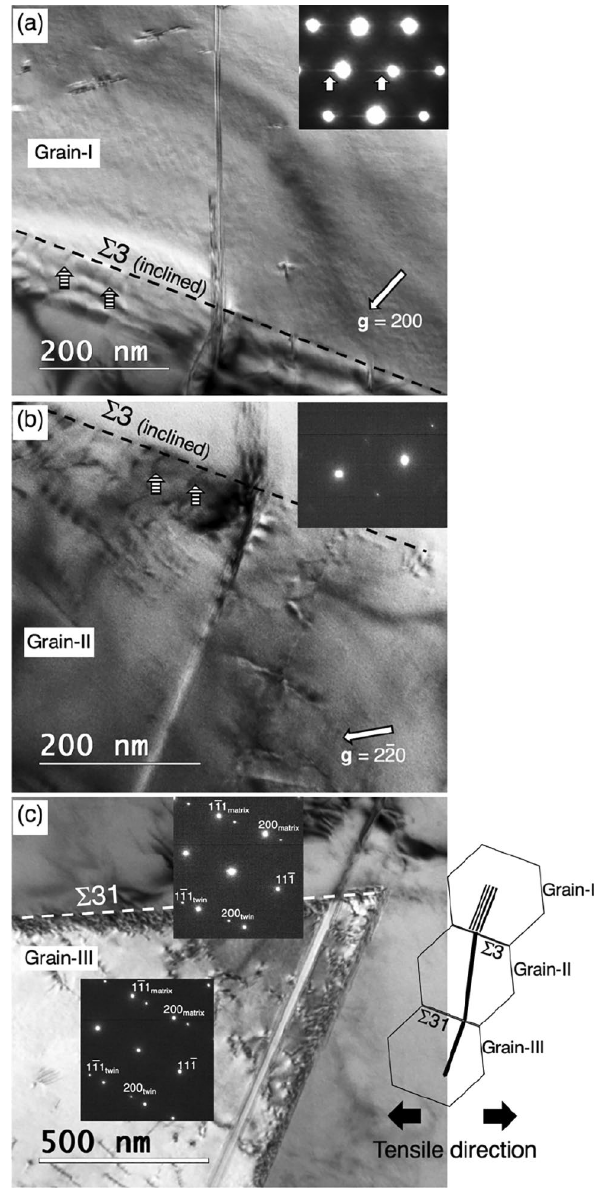
Figure 4. ( a ) A BF TEM image shows a stacking fault in the impingement region of an inclined Σ3{111} boundary. The inset SAED pattern shows faint streaks ascribed to the shape factor of the stacking fault. ( b ) A deformation twin emitted from the Σ31 boundary impinging on the Σ3{111} boundary. Several impingement- induced grain boundary dislocations are indicated by striped arrows. ( c ) Deformation twins were nucleated from a Σ31 boundary. The inset [ 0 ¯ 1 ¯ 1 ] zone axis SAED patterns were taken from each of fine deformation twins. A schematic illustration is provided to indicate the geometrical relationship of two twinned grains (Grain-II and Grain-III) and one grain having a stacking fault